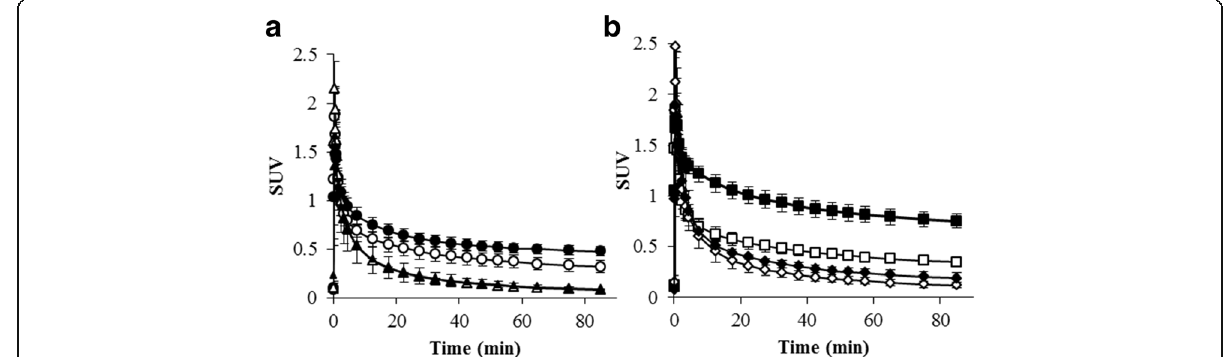
Fig. 3 Hepatic time activity curves after 18 F-FPP-RGD 2 injection in mice fed a control ( a ) or methionine choline-deficient, L -amino acid-defined, high-fat diet (CDAHFD) ( b ) ( n = 5 per group). Sixty micrograms of c(RGDfK) was co-injected with 18 F-FPP-RGD 2 into each group for the blockade study ( n = 3 per group). white circle, control 3 weeks; black circle, CDAHFD 3 weeks; white triangle, control 3 weeks + cRGDfK; black triangle, CDAHFD 3 weeks + cRGDfK; white square, control 8 weeks; black square, CDAHFD 8 weeks; white diamond, control 8 weeks + cRGDfK; and black